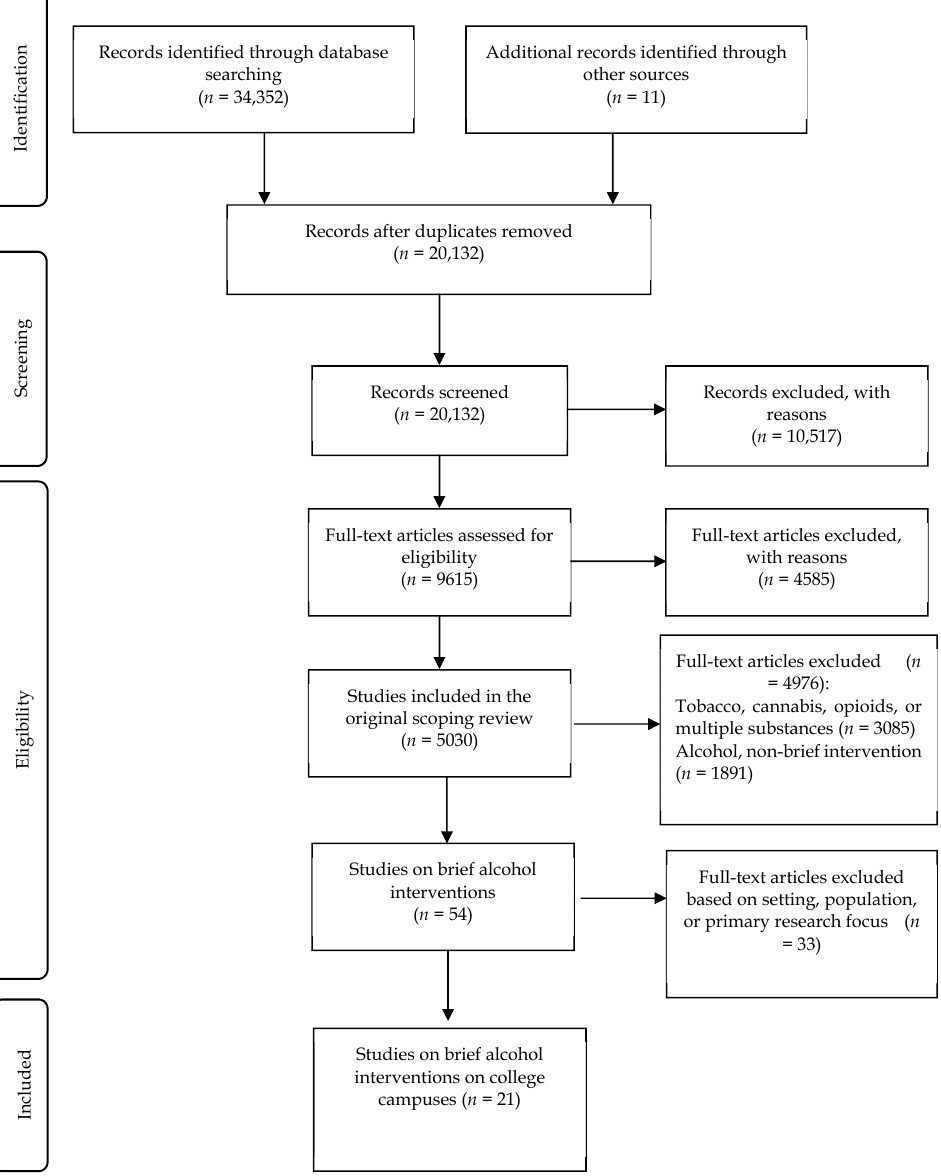
Figure 1. The Preferred Reporting Items for Systematic Reviews and Meta-analysis (PRISMA) flow diagram adapted from Moher et al. (2009) [23] for the scoping review process [24] .